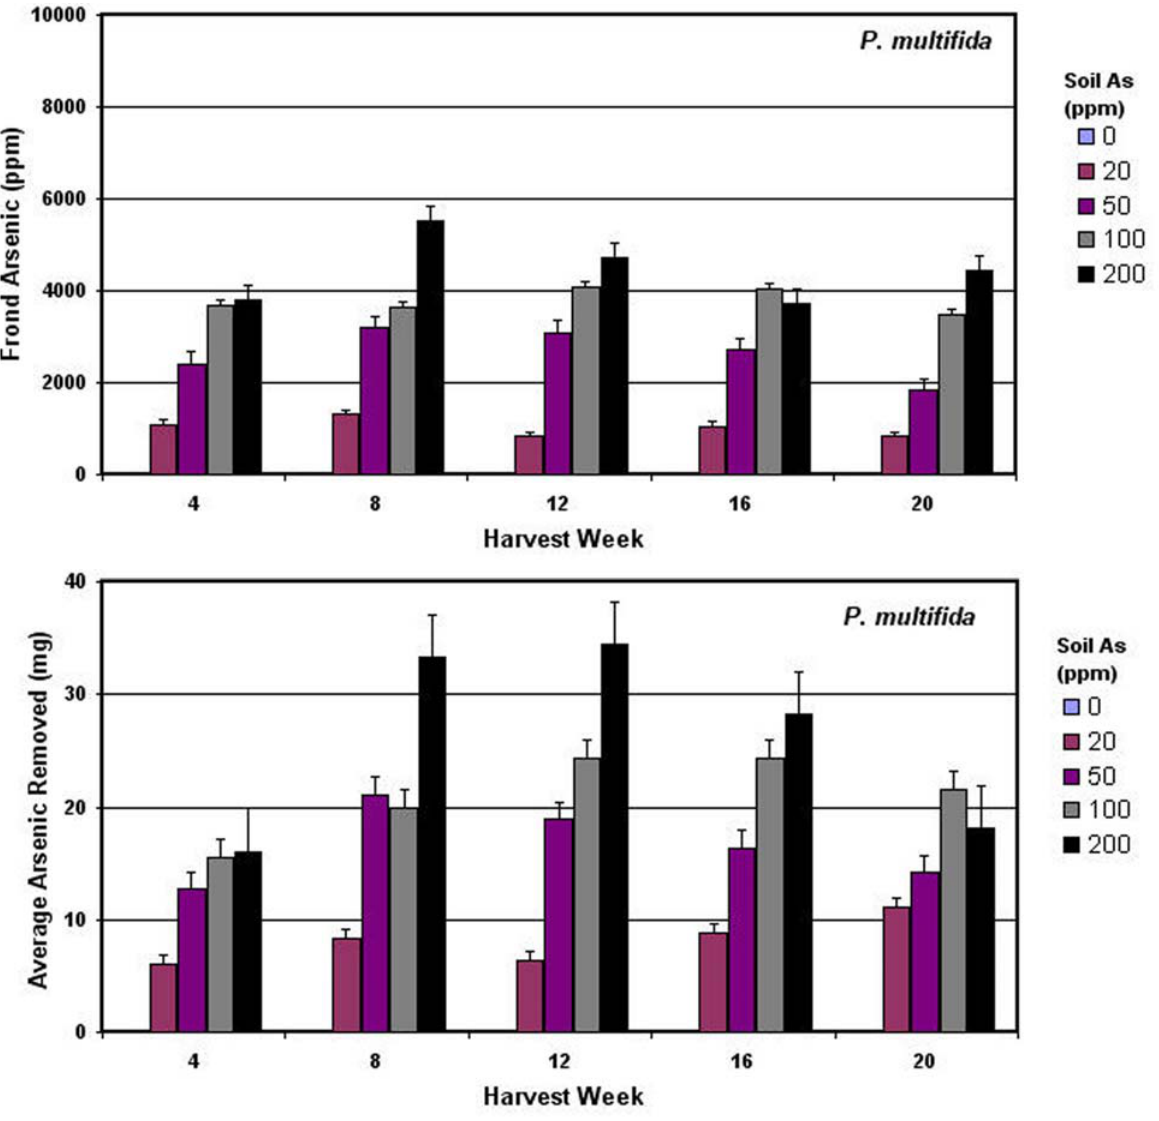
Figure 8. Arsenic Uptake Summary for Pteris multifida . Arsenic concentration and content in the arsenic-hyperaccumulating fern Pteris multifida . Peak concentration and content were observed between eight and 12 weeks and, like, Pteris cretica mayii accumulated more arsenic from the 100 ppm concentration than from the 200 ppm concentration in some cases. Table 3 lists uptake values by week and soil